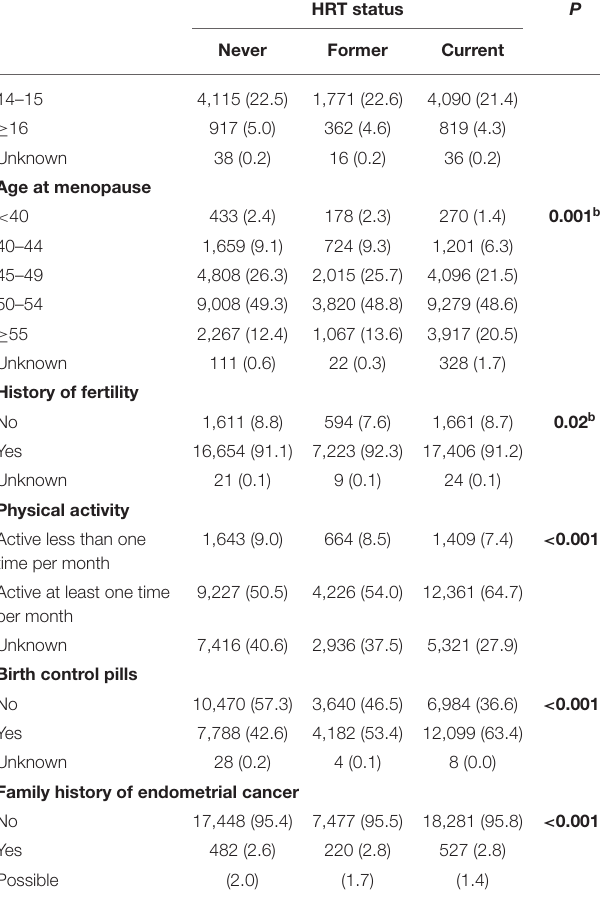
TABLE 1 | Baseline characteristics of female subjects by status of hormone replacement therapy (HRT) in the PLCO screening